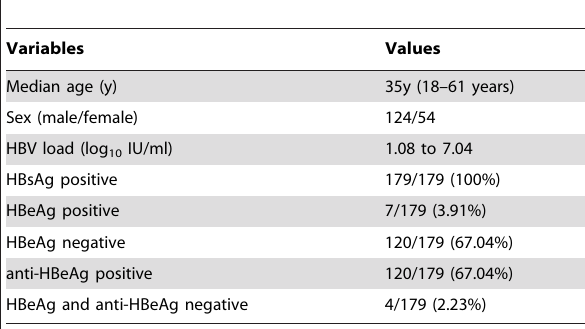
Table 2. Clinical profiles of HBsAg-positive patients of Oman.